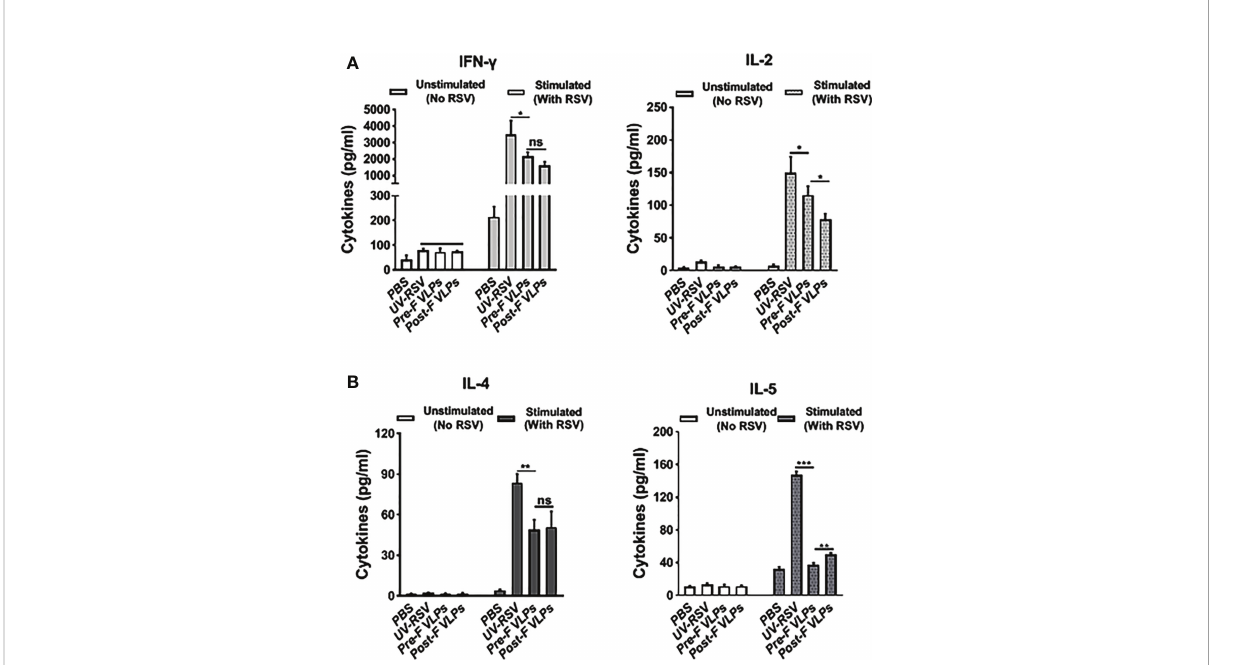
FIGURE 4 VLPs elicited cellular immune responses in mice. Spleen cells were isolated at 2 weeks after the last immunization and stimulated with 1×10 5 PFU of puri fi ed UV-inactivated RSV. The supernatants were collected after 72 h of incubation, and Th1 cytokines (IFN- g and IL-2) (A) and Th2 cytokines (IL-4 and IL-5) (B) concentrations were measured by ELISA. All data are presented as the mean values (± SD) from fi ve mice in each group. P values were calculated with one-way ANOVA or Student ’ s t test followed by the Tukey test. *** P < 0.001; ** P < 0.01; * P < 0.05; ns, not signi fi